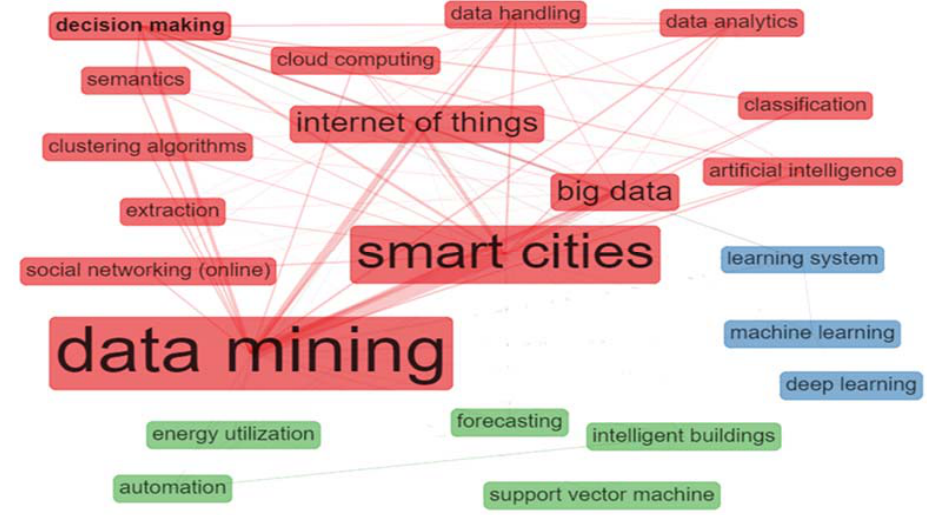
Figure 12. Co-occurrence word network.